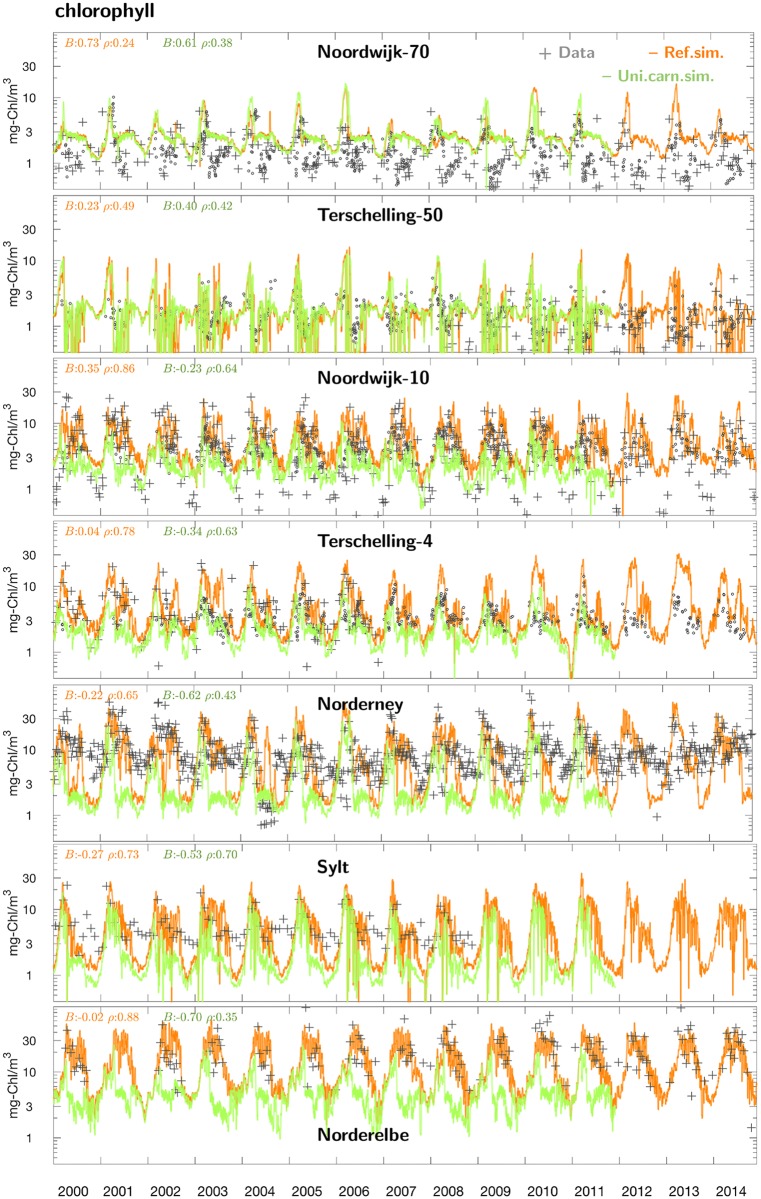
Long-term dynamics of at 7 stations in the southern North Sea.The stations are ordered according to the distance to the coast with the most offshore station (Noordwijk-70) at the top. Compiled measurements (gray crosses) are compared to the reference run (orange line) and the run with spatially uniform carnivory (green line). This scenario is only plotted until end of 2011 for better visibility. Normalized bias B and correlation coefficient ρ of the model–data comparison are added in the color of the respective scenario.